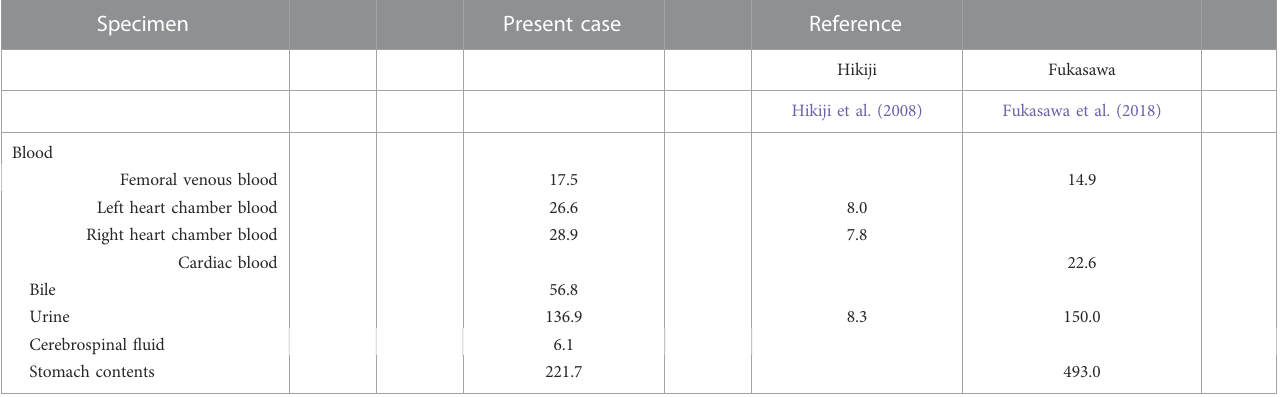
TABLE 2 Pilsicainide concentration in the body fl uids associated with fatal intoxications reported in the scienti fi c literature (µg/mL).